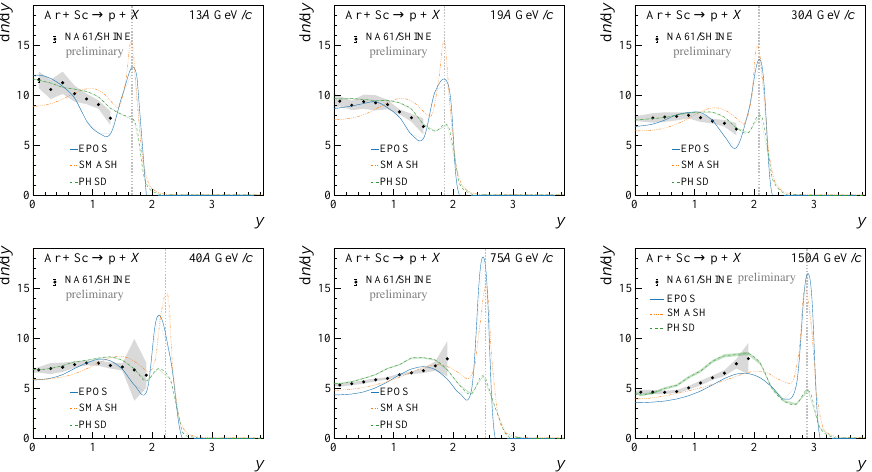
Figure 5: Comparison of the proton rapidity spectra in central Ar + Sc collisions at 13 A – 150 A GeV / c with E pos 1.99 [6], P hsd 4.0 [14, 15] and S mash 1.6 [16, 17] models. The grey dashed vertical line is plotted at the beam